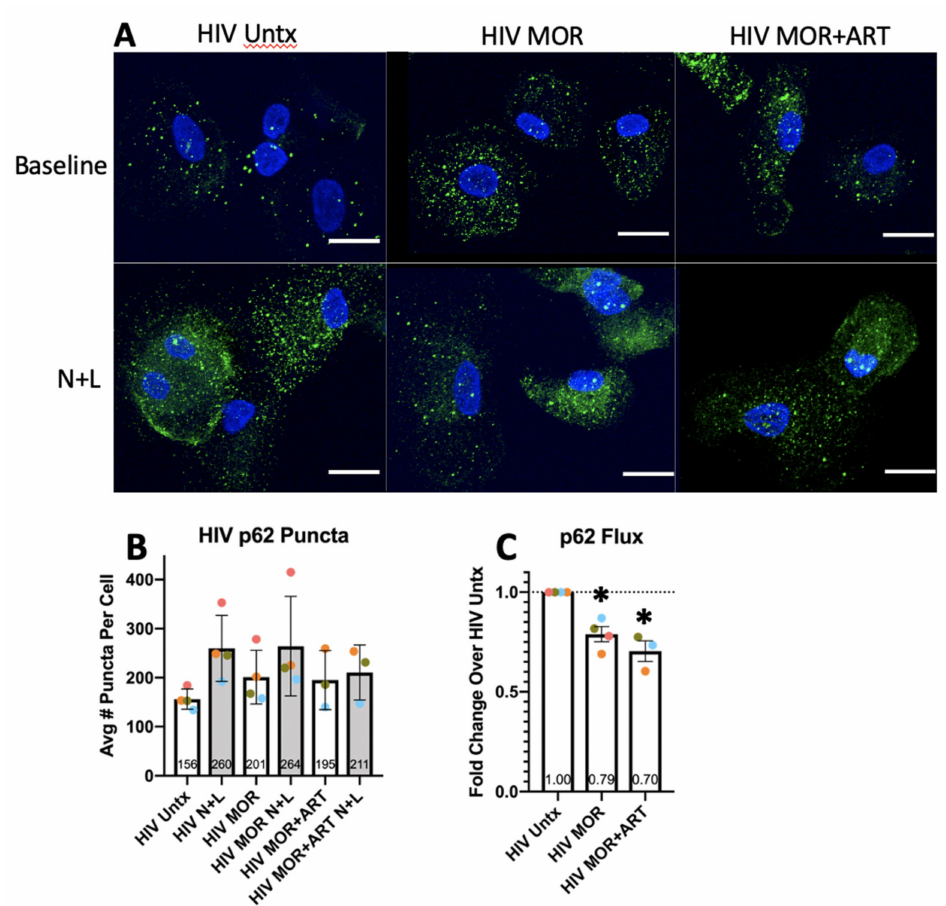
Figure 5. p62 immunofluorescence studies in HIV-infected MDM. Primary human macrophages were cultured on coverslips, infected with HIV for 3–4 days, and left untreated (HIV Untx) or treated with morphine and/or ART for 24 h with N+L added to some cells in the last 4 h of treatment. Coverslips were stained for p62 and imaged by confocal microscopy in Z-series, and p62 puncta/cell were deter- mined with size and intensity thresholds set individually for each experiment. ( A ) Representative infected untreated cells or cells treated with morphine and/or ART with/without N+L. ( B ) Average number of p62 puncta per cell across treatments. ( C ) p62 flux was calculated relative to untreated control set to 1.0. Scale bar is 15 µ m. Puncta/cell were quantified in a blinded manner in 40–80 cells per treatment condition for each experiment and averaged. Error bars for puncta values represent SD, and error bars for p62 flux represent SEM, n = 3–4 independent experiments, * p < 0.05 one-sample t